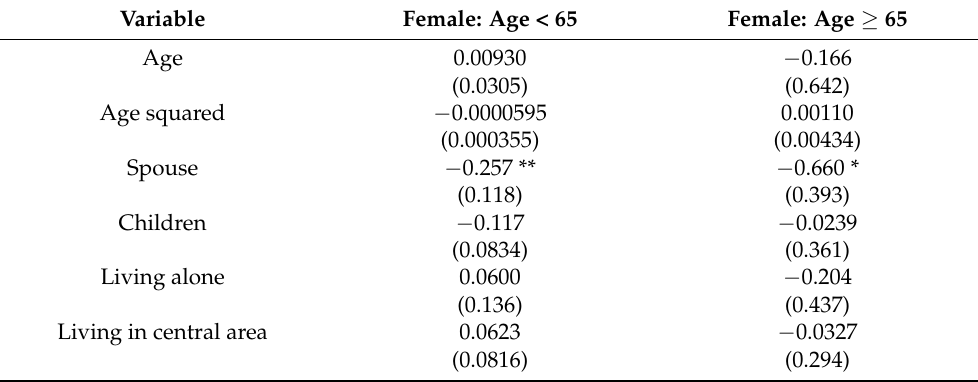
Table 4. Results of probit regression analysis regarding younger and older females’ reluctance to receive the third dose of COVID-19